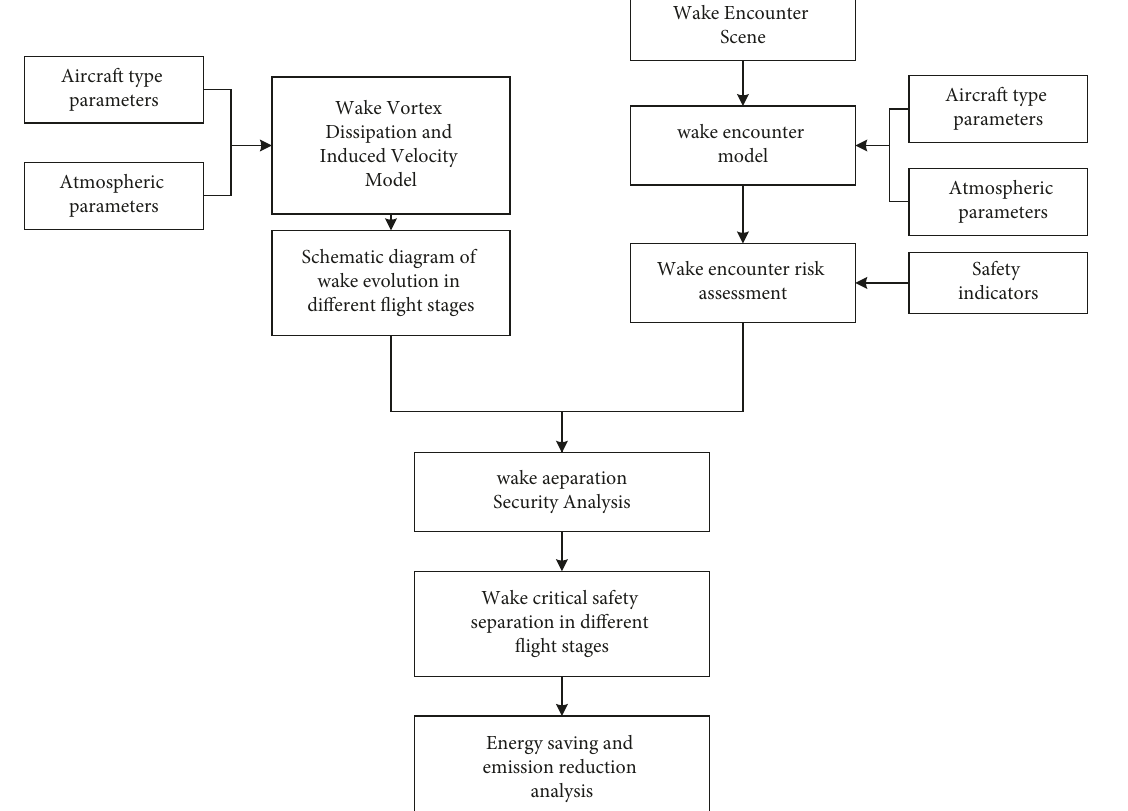
Figure 1: The framework of this